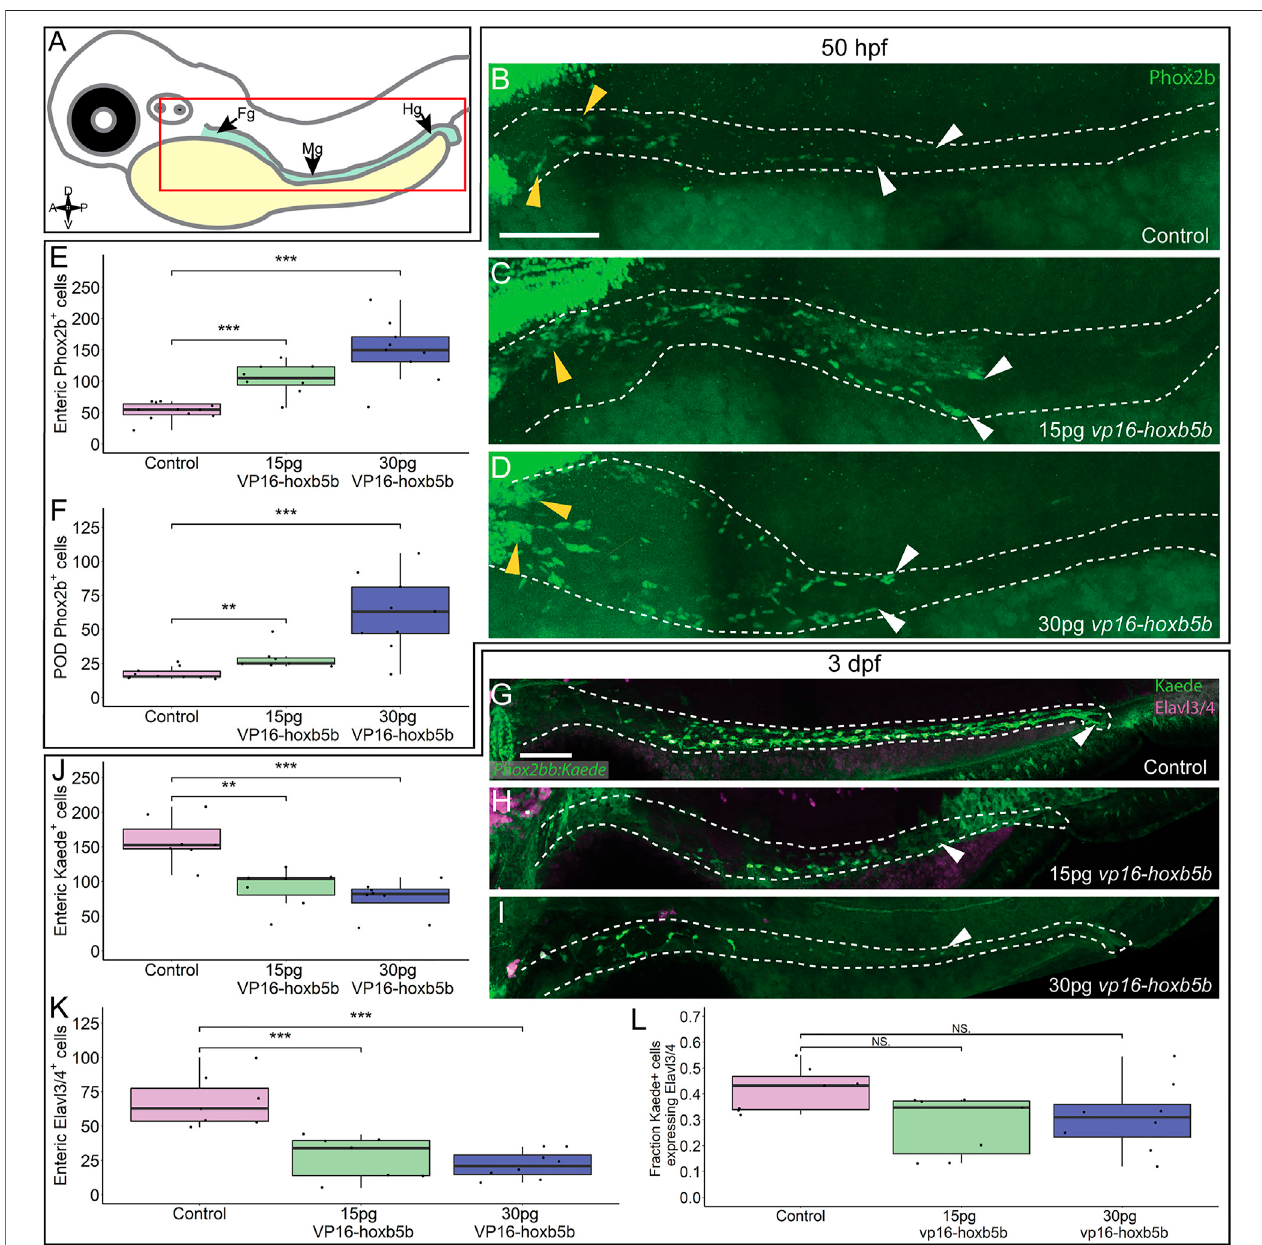
FIGURE 5 | Hoxb5b is suf fi cient to expand early enteric neural progenitors. (A) Schematized model of a zebra fi sh embryo highlighting the region of the gut tube, whichisimagedinthefollowingpanels. (B – D) WholemountIHCforPhox2bin50 hpfcontrolembryos[ (B) , n (cid:1) 10]comparedtoembryosinjectedeitherwith15 pg[ (C) , n (cid:1) 7]or30 pg[ (D) , n (cid:1) 9]of vp16-hoxb5b mRNA.YellowarrowheadsindicatedPODlocalizedPhox2b + cells,whitearrowsdesignateterminalendofentericNCCchain, which falls within the gut tract outlined with white dashes. (E,F) Quanti fi ed cell numbers from the same animals reveal a coordinate increase in Phox2b + along the gut axis at 50 hpf trending with increasing vp16-hoxb5b mRNA amounts [ (E) , 15 pg: p (cid:1) 2.834 × 10 – 5 ; 30 pg: p (cid:1) 0.00318]. Additionally, the number of Phox2b + cells restricted to the POD also increased in response to elevated Hoxb5b activity [ (F) , 15 pg: p (cid:1) 0.00328; 30 pg: p (cid:1) 0.00068]. (G – I) Whole mount IHC on 3 dpf -8.3 phox2bb:kaede embryos with antibodies against Elavl3/4 and Kaede, marking the enteric NCC lineage cells in vp16-hoxb5b overexpressing animals (15 pg n (cid:1) 8; 30 pg n (cid:1) 7) compared to uninjected sibling controls ( n (cid:1) 7). (J – L) Quanti fi cation of the number of enteric neural progenitors [ (J) , 15 pg: p (cid:1) 0.00011; 30 pg: p (cid:1) 4.09 × 10 – 5 )anddifferentiatingentericneurons[ (K) ,15 pg: p (cid:1) 0.001352;30 pg: p (cid:1) 0.0001042]at3 dpfshowdecreasingnumbersofbothcellpopulations.However,thetotal fraction of differentiating (Hu + ) NCC-derived Kaede + cells unchanged following elevated Hoxb5b activity [ (L) , 15 pg: p (cid:1) 0.0.1282; 30 pg: p (cid:1) 0.102]. Scale Bar (B,G) : 100 μ M.